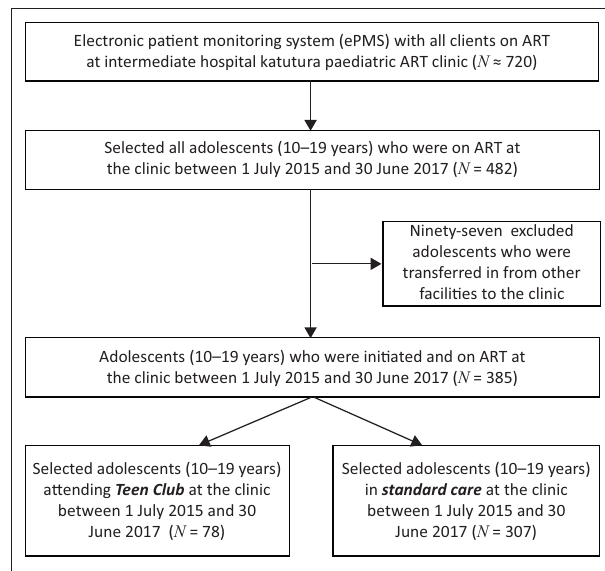
FIGURE 1: Flow chart of the sampling process for the